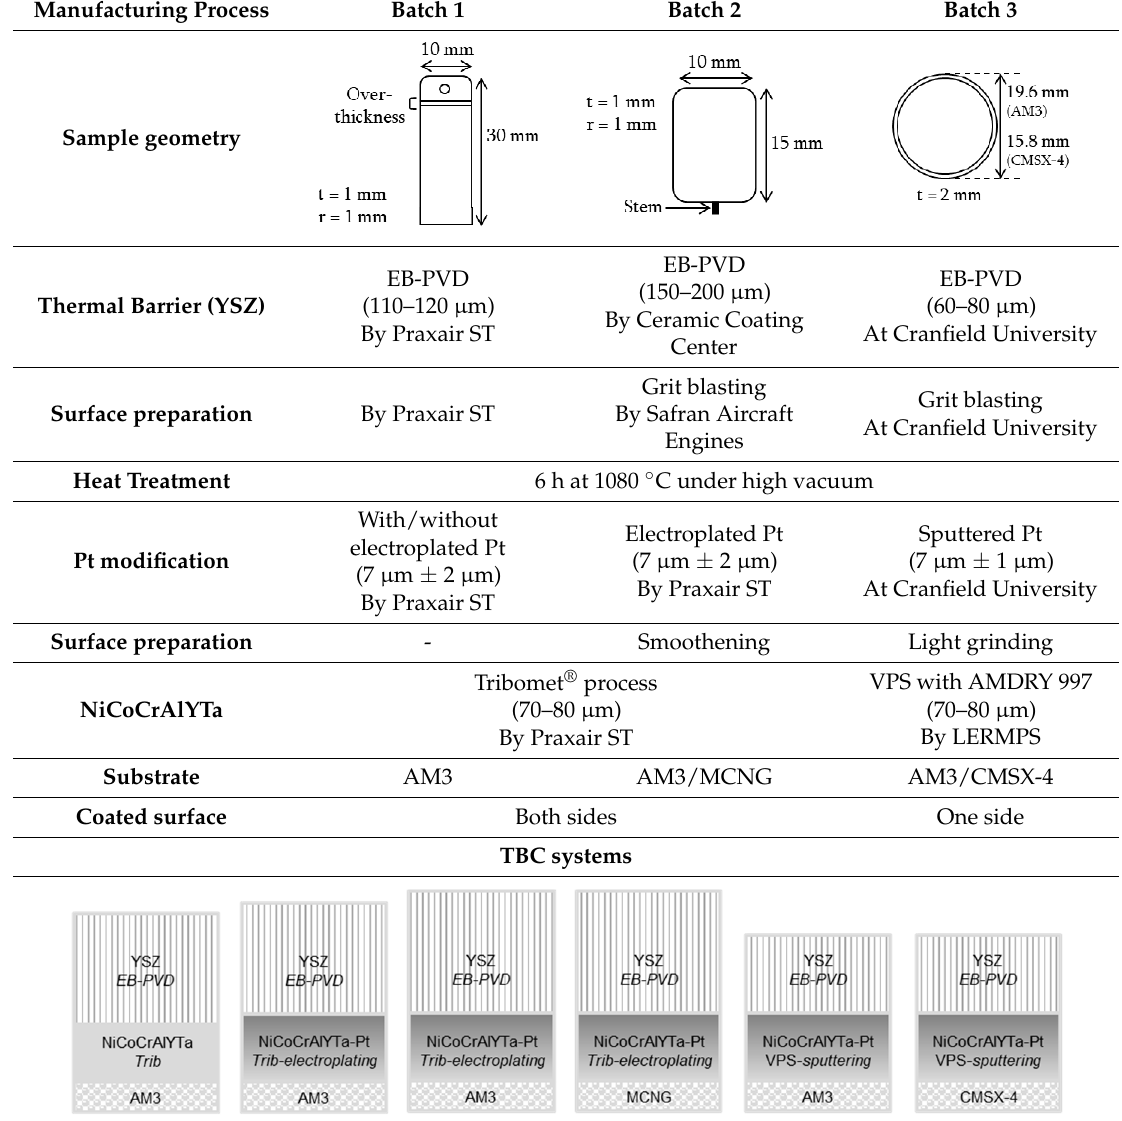
Table 2. Details on the geometry and manufacturing process of the three batches of thermal barrier coating (TBC) systems. ‘t’ represents the thickness, ‘r’ the curvature radius of the edges.